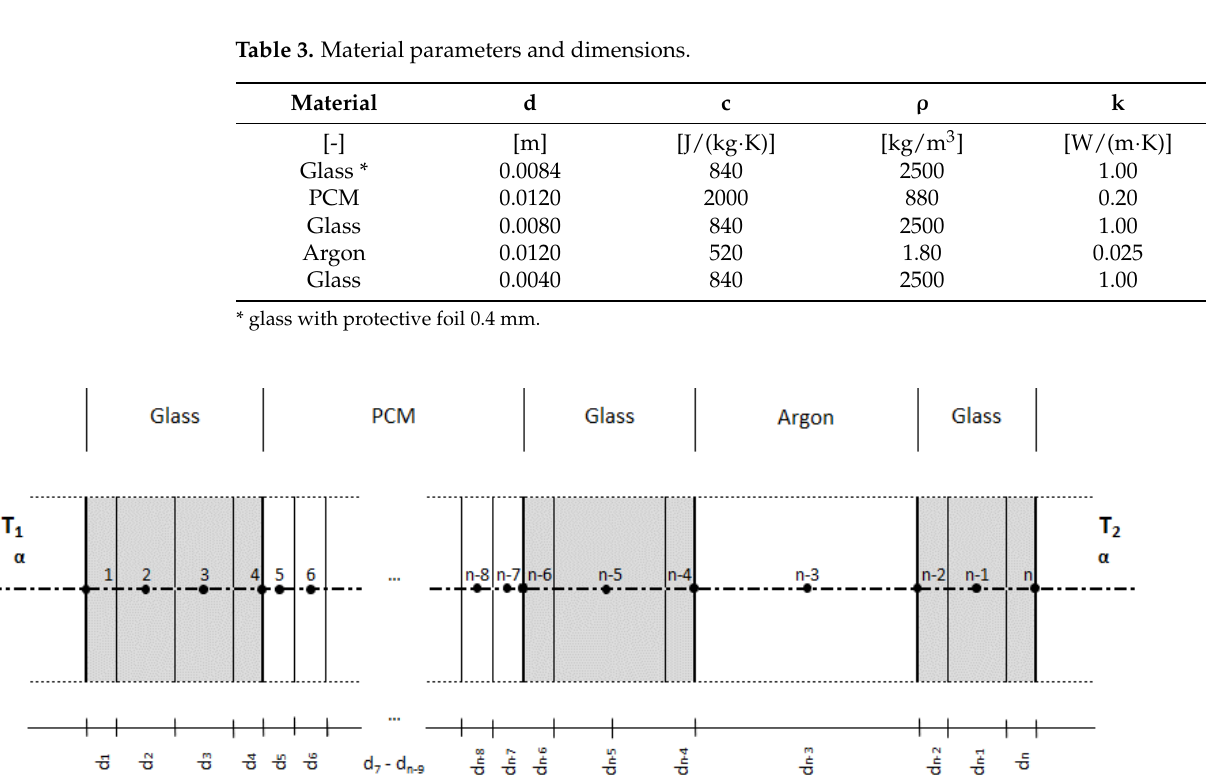
Figure 4. Discretization of the geometrical domain.